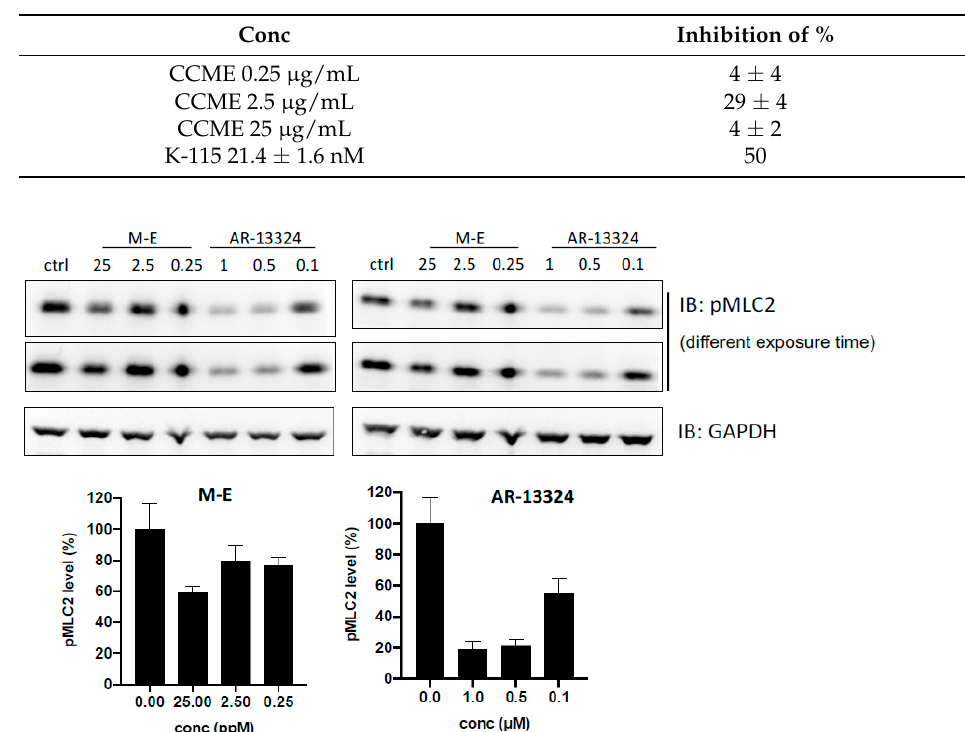
Figure 3. pMLC2 inhibition for CCME and ROCK inhibitor AR-13324 by Western blot.